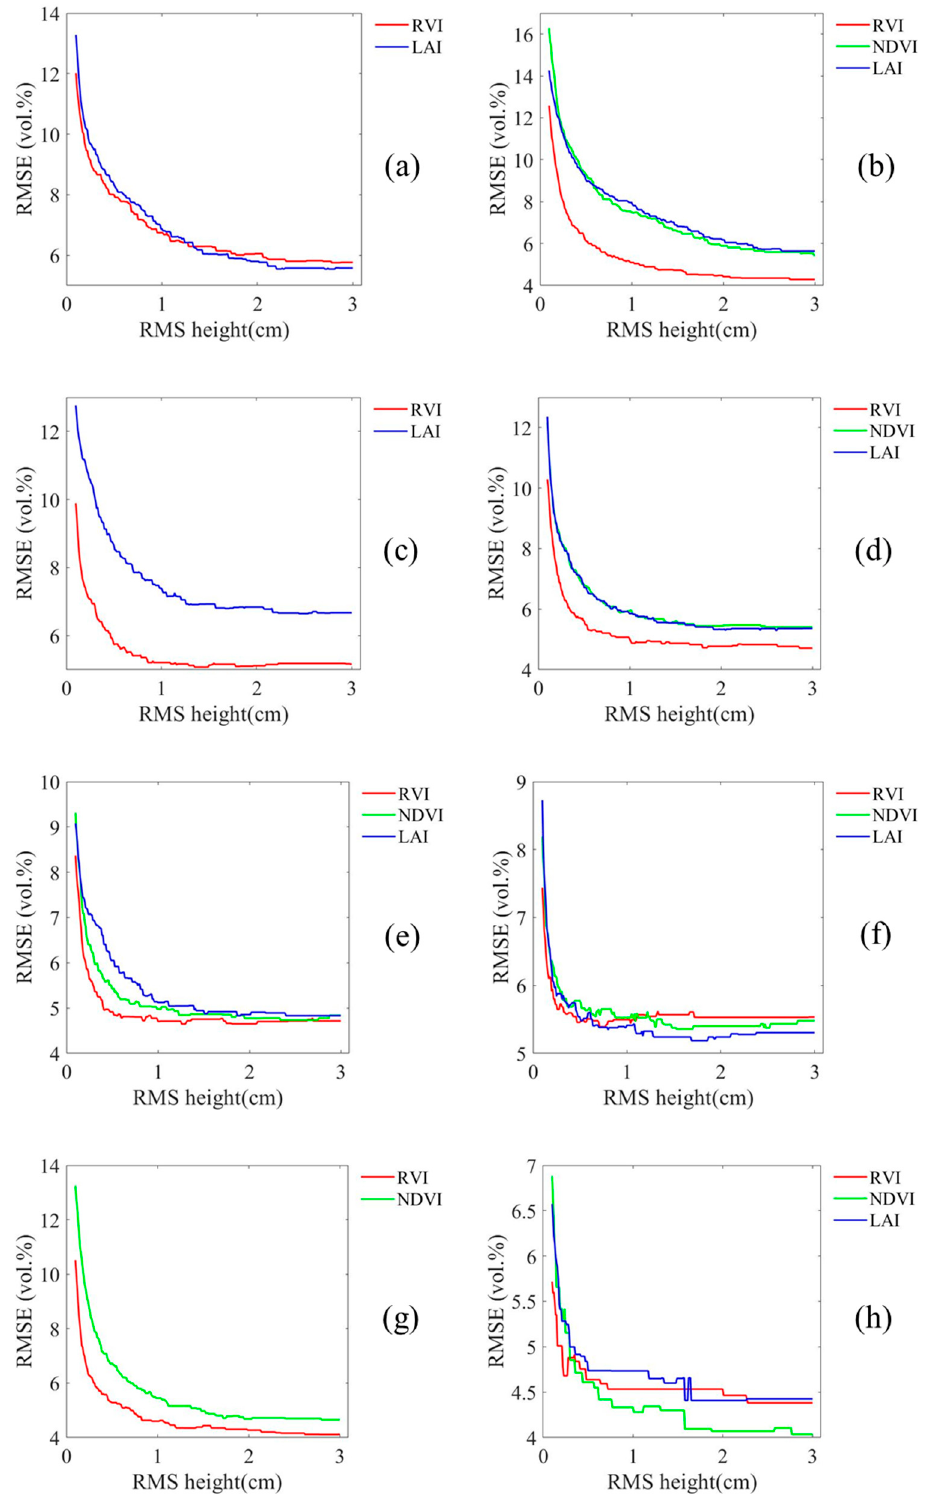
Figure 4. SMC estimation accuracy on the training set with different roughness parameters (Ratio method), ( a ) 9 May, ( b ) 16 May, ( c ) 20 May, ( d ) 29 May, ( e ) 2 June, ( f ) 9 June, ( g ) 16 June, ( h ) 10 July in 2019.